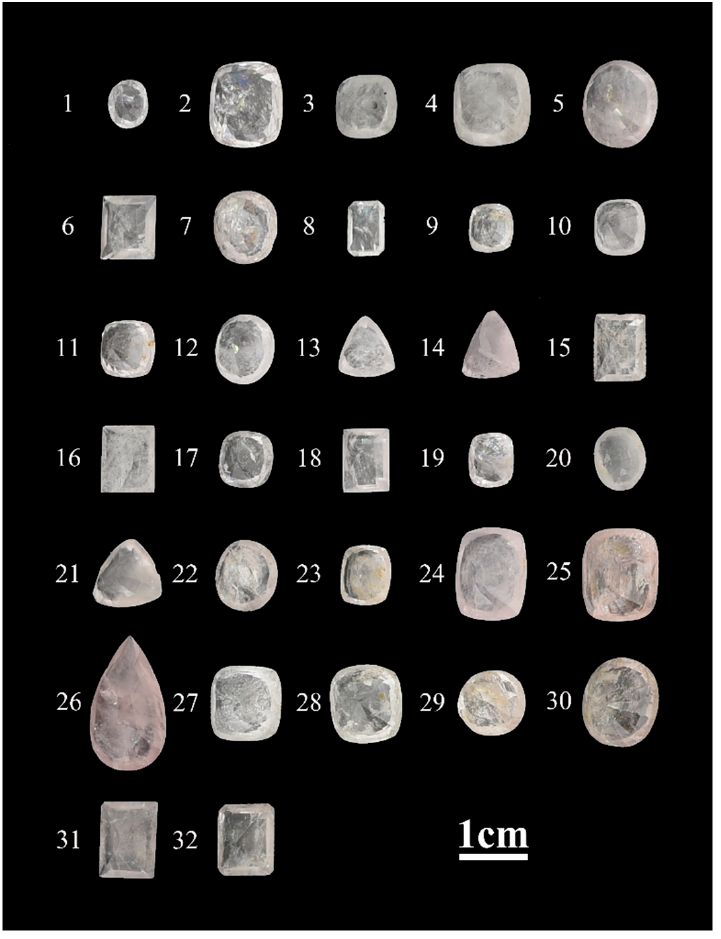
Figure 2. Thirty-two taaffeites from Mogok,